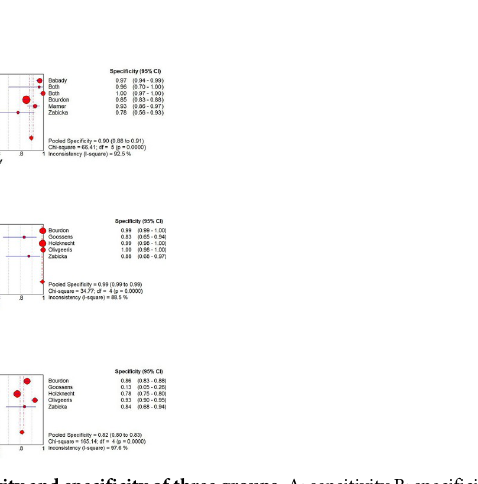
Fig 5. Forest plots for the pooled sensitivity and specificity of three groups. A: sensitivity B: specificity.